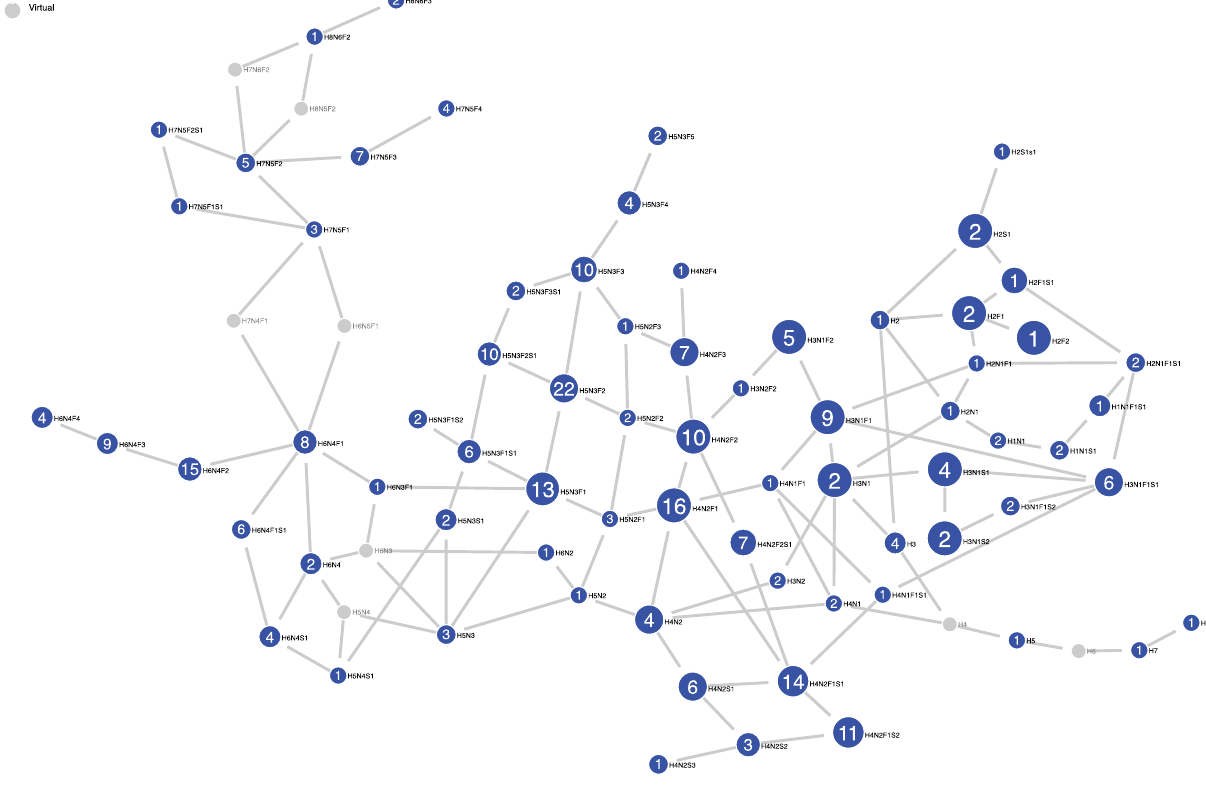
Figure 6. Network of HMO compositions. Nodes represent distinct compositions of hexose, N -acetylhexosamine, fucose and sialic acid residues, and differ by one monosaccharide unit from each of their nearest neighbours. Numbers on blue nodes refer to the number of structures in GlyConnect 80 with the composition. Virtual nodes (grey) represent unknown structural